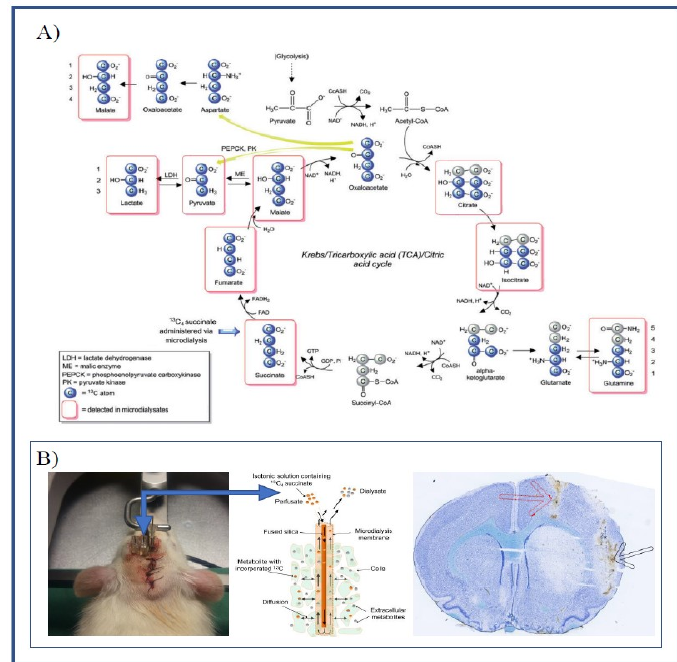
Figure 1. ( A ) Schematic illustration of the metabolism of 13 C 4 succinate via the TCA cycle and spin-out pathways. Blue-filled circles indicate 13 C atoms. Red rectangular outlines indicate metabolites detected by LC-MS analysis. Modified from: Jalloh, Ibrahim et al. “Focally perfused succinate potentiates brain metabolism in head injury patients”. Journal of Cerebral Blood Flow and Metabolism 37, nr. 7 (July 2017): 2626–2638. ( B ) Illustrating the placement of guide cannulas in the left hemisphere (left) and brain histology using cryosectioning and Nissl staining (right), showing the placement of the microdialysis catheter in the striatum (black arrow) and catheter for ET-1 infusion (red arrow). Schematic of catheter illustrating the diffusion of labeled substrate and metabolites (middle) modified from: [10].